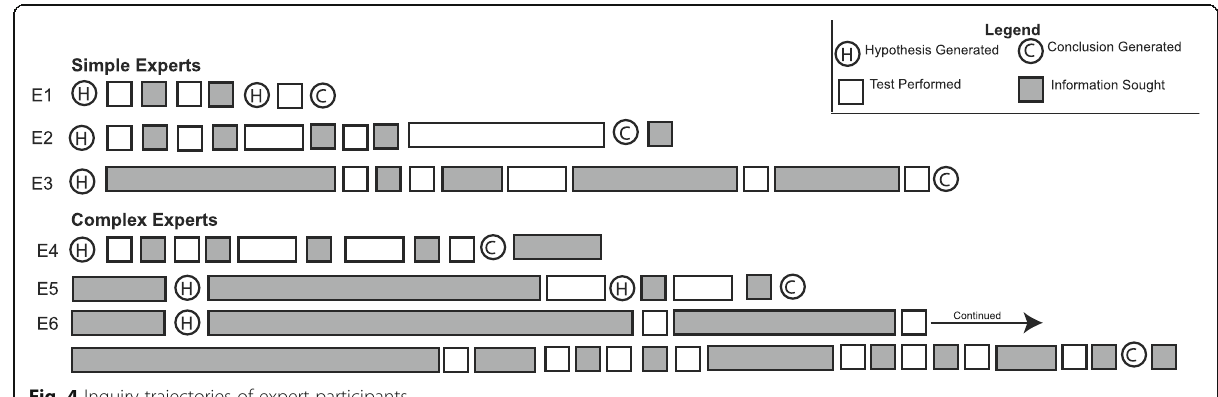
Fig. 4 Inquiry trajectories of expert